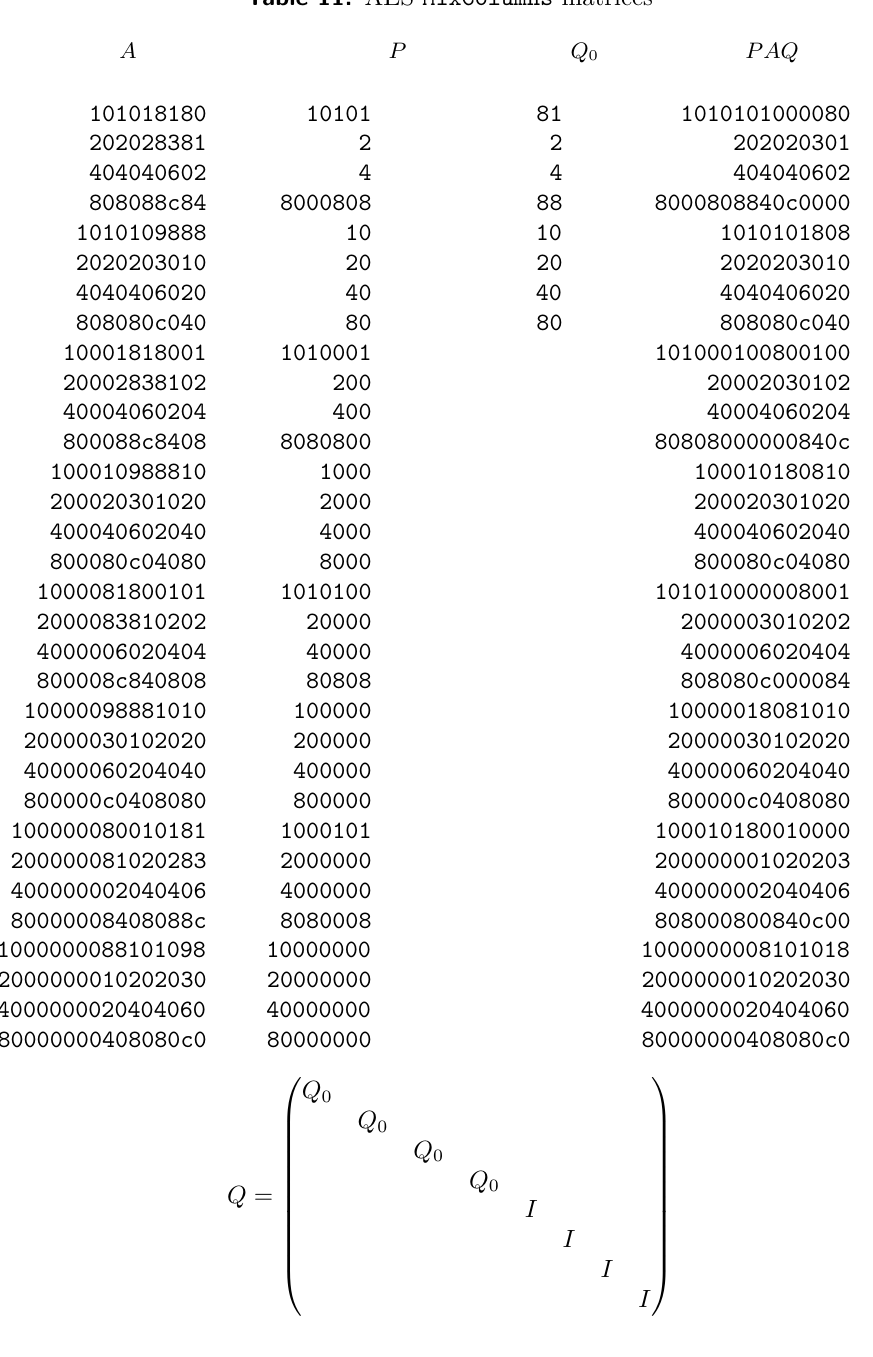
Table 11: AES MixColumns